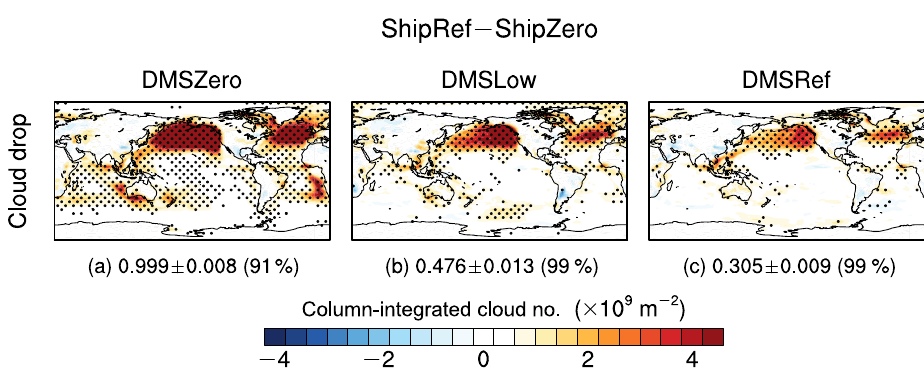
Figure 7. Spatial patterns of MARC-simulated column-integrated cloud droplet number concentration ( × 10 9 m − 2 ) response to international shipping emissions. The responses are calculated as the differences of cloud droplet number integrated through the whole atmospheric column between the simulation without shipping emissions and three simulations with the reference shipping emissions and various DMS emissions (i.e., zero, low, and reference) over the 30-year simulation period. The numbers below each panel are the global means, standard deviation across the 30-year period, and the confidence level. The black dots represent grid points that are statistically significant above the 90% confidence level based on the two-tailed Student’s t test.